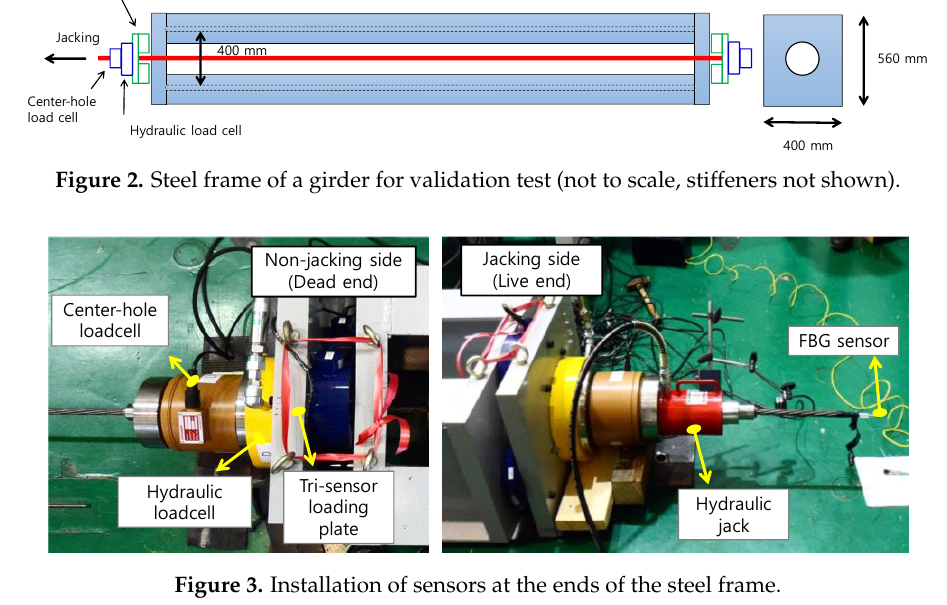
Figure 3. Installation of sensors at the ends of the steel frame.